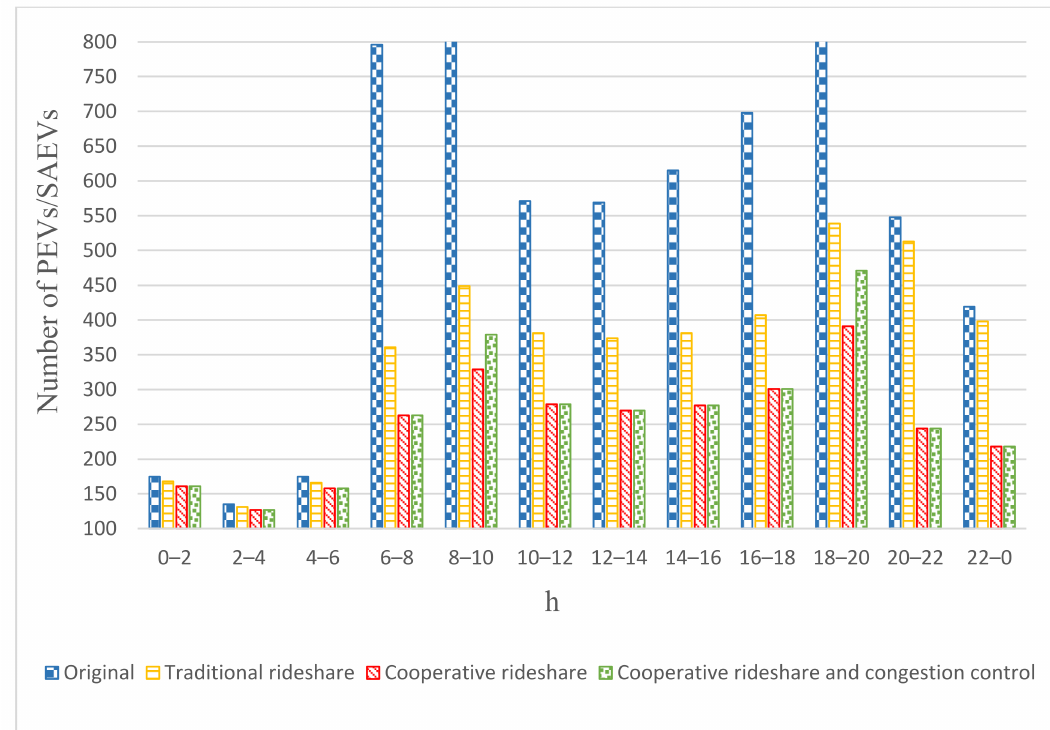
Figure 12. Traffic volumes of PEV/SAEV passengers on minor arterial 2.